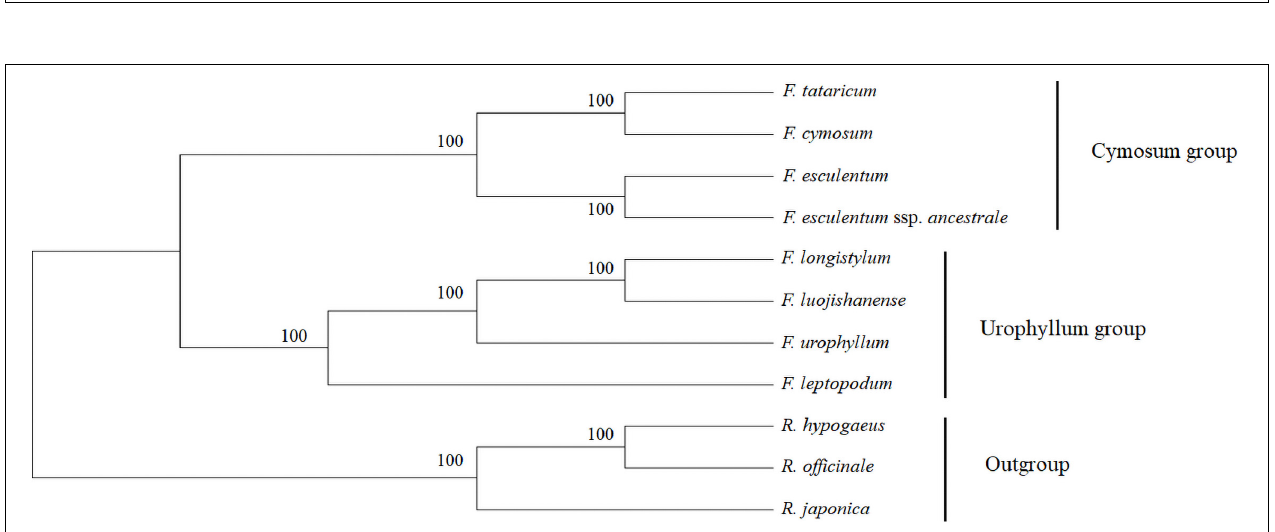
FIGURE 7 | Phylogenetic tree obtained for eight Fagopyrum species inferred from ML analysis constructed by the complete chloroplast genomes. The number on the branches displayed the bootstrap support values.